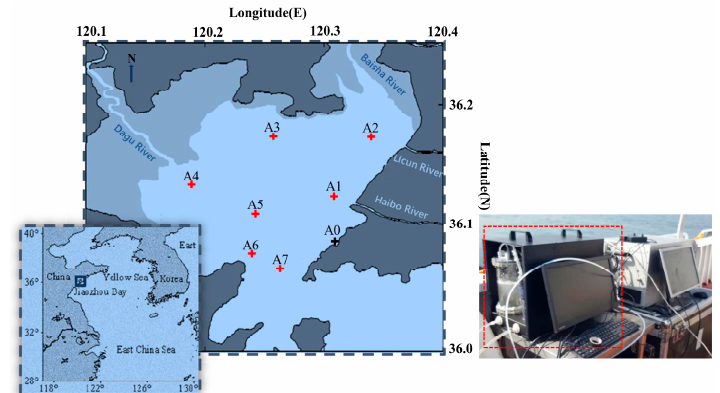
Figure 9. Experimental stations of underway measurement. The A0 station (wharf) was where the employment began. The experiment was performed in an anticlockwise direction. The stations were chosen by the following factors: surface runoff, human activities and special geographic positions (the bay center and the bay mouth).